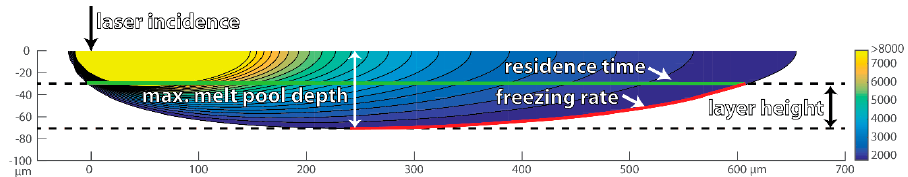
Figure 5. Schematic depiction of the simulated melt pool geometry (i.e., melting temperature isotherm). Some additional isotherms inside the melt pool are shown as well. The freezing rate is averaged over the region marked in red and the residence time is calculated using the length marked in green.